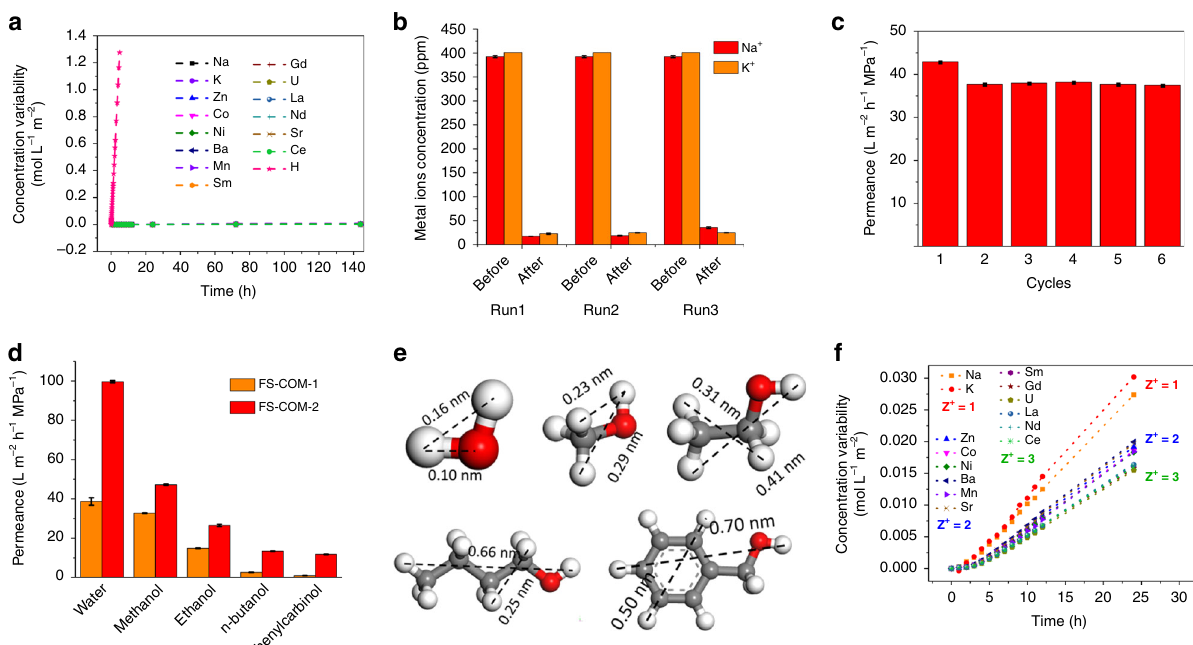
Fig. 5 Membrane performance study. a Concentration variability of 14 coexisting cations in the permeate part for FS-COM-1. The multi-ion solution containing 14 coexisting cations was prepared by dissolving the desired metal oxides or nitrates in concentrated nitric acid and then diluting them with deionized water. b Na 2 SO 4 or K 2 SO 4 rejection performance of FS-COM-1 at 0.1 MPa in the three fi ltration cycles. c Water permeance of FS-COM-1 for six fi ltration cycles. d Permeance of solvents with increasing sizes for FS-COM-1 and FS-COM-2. e Molecular sizes of the selected solvents calculated by MS. f Concentration variability of 14 coexisting cations in the permeate part for FS-COM-1-VF. The error bars in b and d show standard deviations based on three independent measurements. The red, gray, and white spheres represent O, C, and H atoms, in Supplementary Fig. 28 and related part. Our experimental Fig. 34. The number in the green box is the photo shooting time. results indicate that all the 14 cations tested could not permeate As we can see, FS-COM-2 is very easy to absorb water, proving through FS-COM-1 membrane in ambient conditions, even if the that the material has a good hydrophilic ability. Further analysis fi ltration time lasted for 144 h, while H + can easily pass through of the organic solvent nano fi ltration results reveals that, for FS- the membrane (Fig. 5a). Similarly, no penetration of rhodamine B COM-1, the permeance becomes very slow when the size of (molecule size 1.7 nm × 1.3 nm, Supplementary Fig. 29) was solvent is closer to the membrane pore size, and the permeance of observed in a 72 h fi ltration experiment (Supplementary Figs. 30 phenylcarbinol is only 0.9 L m − 2 h − 1 MPa − 1 which is about 36 times slower than that of methanol. However, for FS-COM-2, the phenylcarbinol permeance is only four times slower than that of methanol (Supplementary Figs. 35 and 36). The apparent size- dependent permeance is related to the difference in pore size between FS-COM-1 and FS-COM-2. We also tried to use FS- COM-1 for membrane separation of noble gases xenon (Xe) and krypton (Kr). Experimental apparatus and detailed experimental conditions are shown in Supplementary Information (Supple- mentary Fig. 37, Supplementary Table 4). The separation of Xe/Kr has important applications in many fi elds, such as atmo- spheric radionuclide monitoring, industrial preparation of noble gases, and spent fuel treatment etc. The conventional method to separate these two gases is fractional distillation at cryogenic temperatures, which is energy intensive and costly. In addition, even after cryogenic distillation, trace levels of radioactive Kr in the Xe-rich phase are too high to permit further use 42 . In prin- ciple, membrane separation can well overcome the drawbacks of fractional distillation. Under the experimental conditions, the permeance of Xr and Kr for FS-COM-1 is 1.158 × 10 − 8 and was calculated to be about 1.12. In order to reduce the test error caused by unbalanced system, we sampled three times every 10 min. The results are shown in Supplementary Table 4. As we can see, the permeance and separation coef fi cient kept unchanged for three consecutive samples. Besides, the selective metal ion separation performance of FS-COM-2 and FS-COM-1-VR in